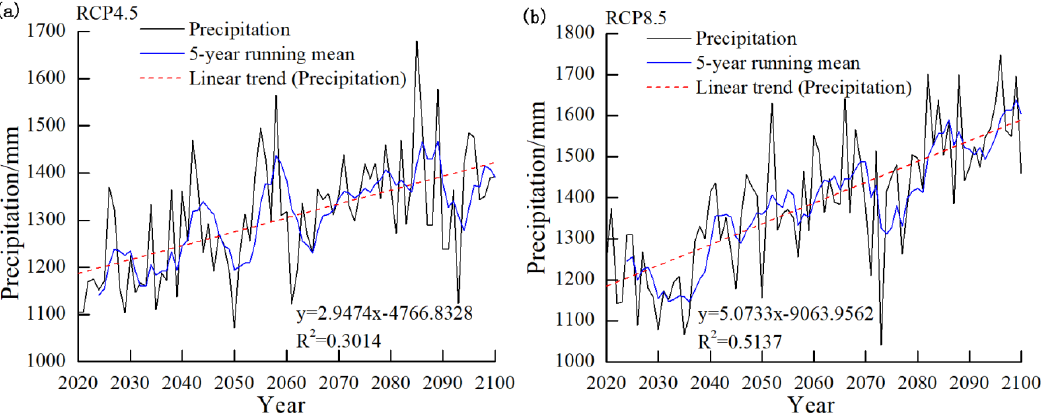
Figure 3. Variation of the annual precipitation in the Lancang–Mekong sub-region under the RCP4.5 ( a ) and the RCP8.5 ( b ).